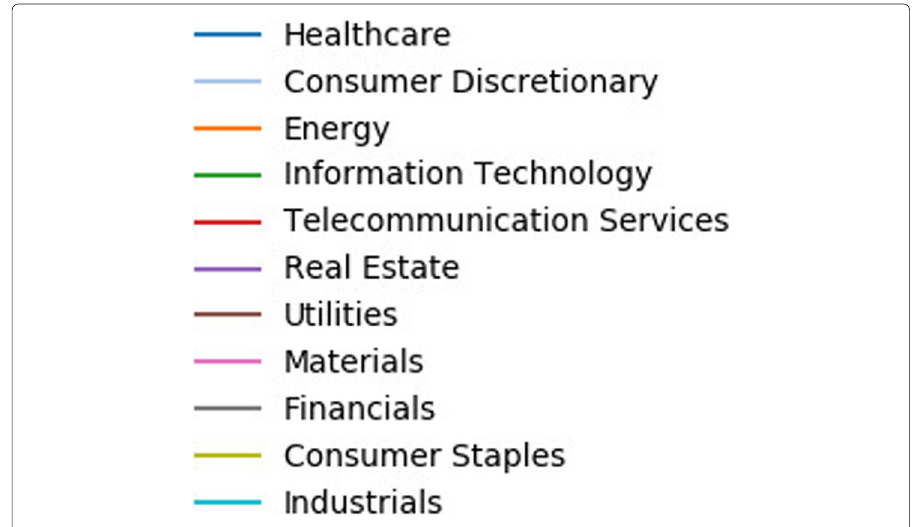
Fig. 8 Legend for the sector colours for Figs. 7 and